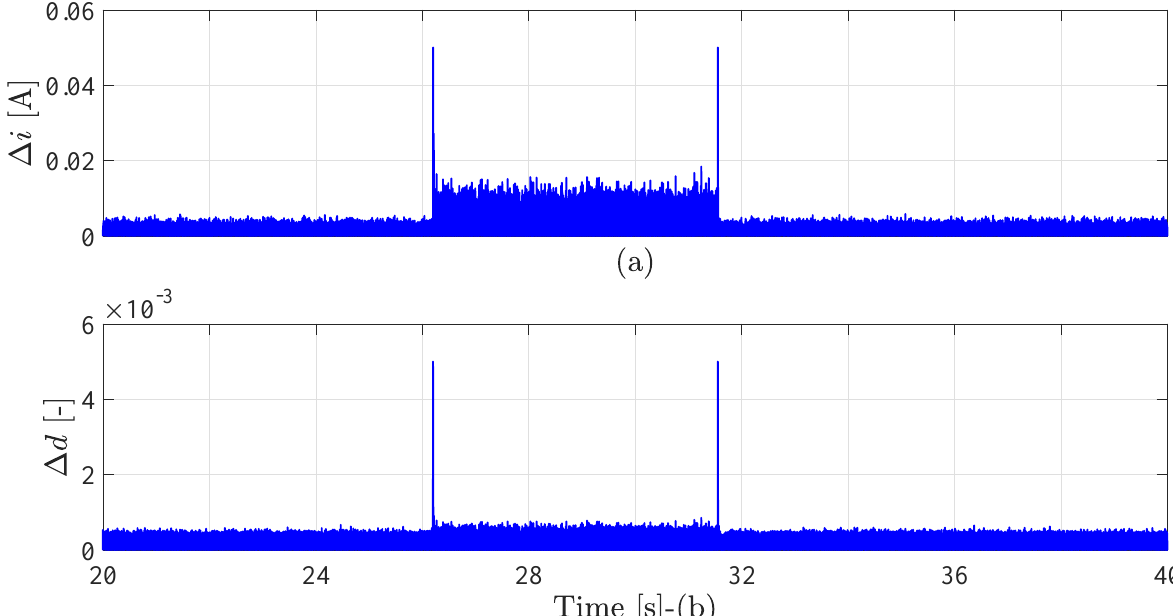
Figure 11. Variation of the adaptive step-size of the proposed predictive method: ( a ) current step-size and ( b ) duty cycle